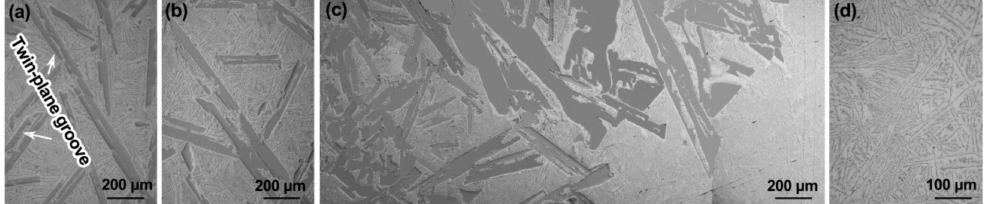
Figure 4. Microstructures of di ff erent positions in Figure 3: ( a ) position 1, ( b ) position 2, ( c ) position 3 and ( d ) position 4.